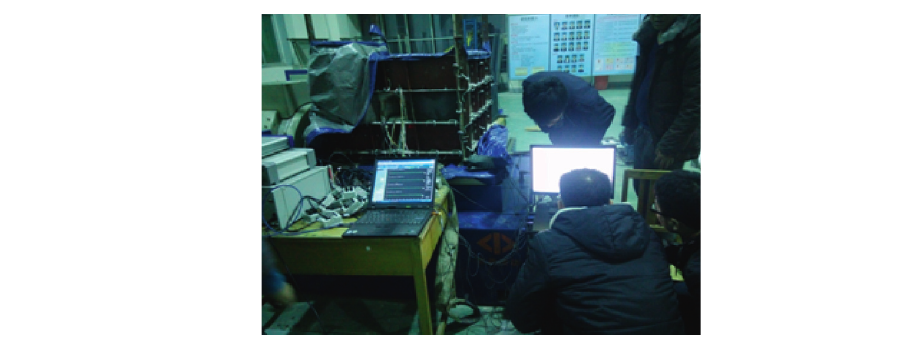
Figure 3: Field of test. Table 3: Parameters of vibration